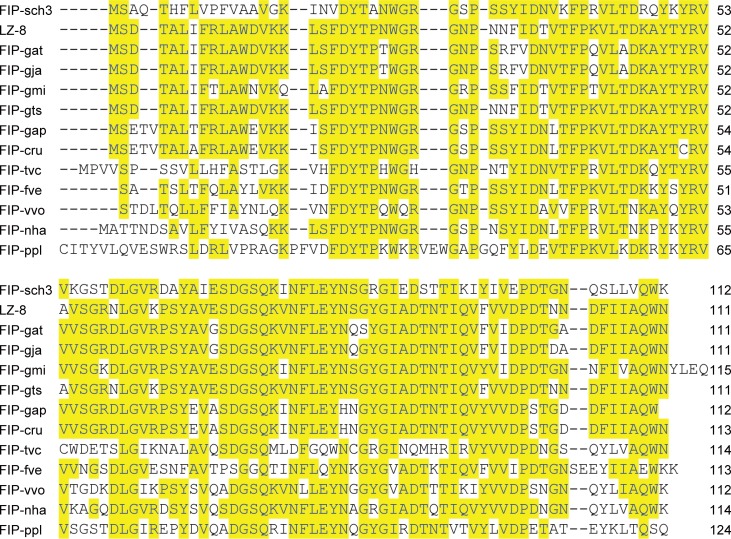
Alignment of FIP-sch3 with other FIPs.The LZ-8, FIP-gat, FIP-gja, FIP-gmi, FIP-gts, FIP-gap, FIP-cru, FIP-tvc, FIP-fve, FIP-vvo, FIP-nha, and FIP-ppl sequences came from G. lucidium, G. atrum, G. japonicum, G. microsporum, G. tsugae, G, applanatum, C. rutilus, T. versicolor, F. velutipes, V. volvacea, N. haematococca, and P. placenta, respectively. Shaded (solid bright yellow) residues match the consensus sequence exactly.